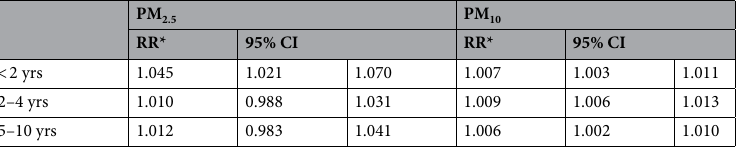
Table 1. The relationship between the PM and the relative risks of acute otitis media according to the three age group. PM 2.5 particulate matter ≤ 2.5 μm/m 3 , RR relative risk, CI confidence interval, yrs years. *Net effect of PM up to 7 days after